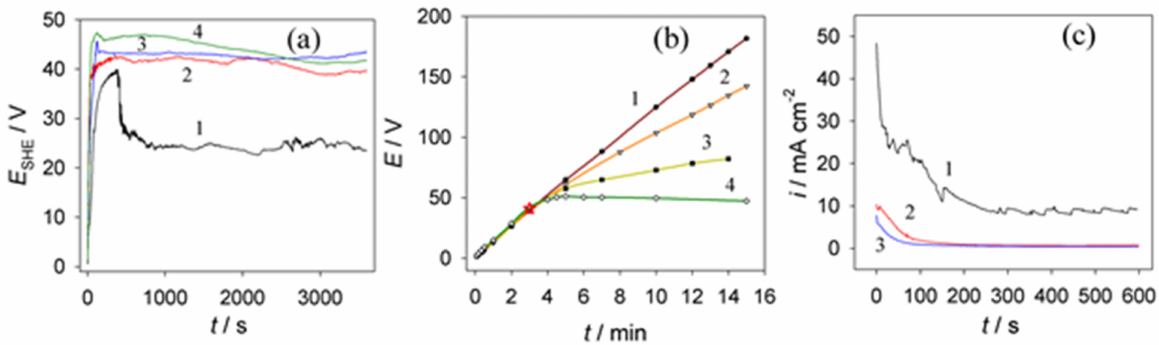
Figure 2. ( a ) E a vs. t plots for 1.0 mol · L − 1 formic acid solution containing 0 (1), 0.01 (2), 0.05 (3), and 0.2 mol · L − 1 NaVO 3 at a pH 2.6, 20 ◦ C, and i a = 5 mA · cm − 1 . ( b ) Same as ( a ) at a current density of 0.5 mA · cm − 2 in a solution containing 0.25 mol · L − 1 NaVO 3 without (1) and with 0.1 (2) or 1.0 mol · L −